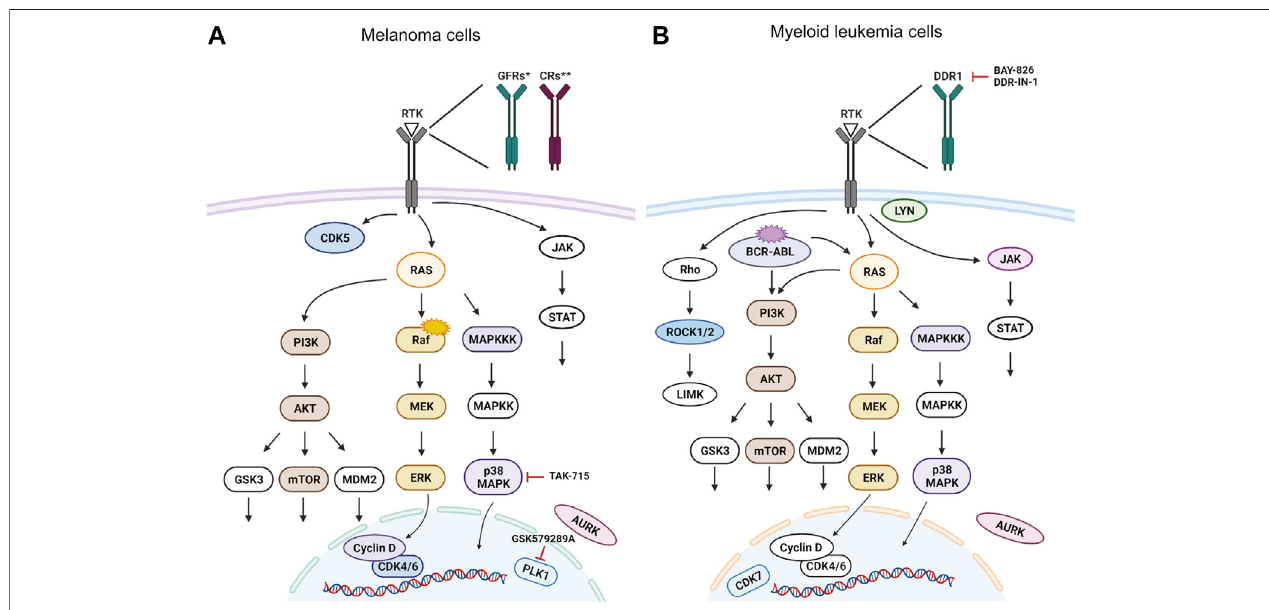
FIGURE 5 | Targeted signaling pathways as predicted from in vivo kinase inhibitor screen. For simplicity, we show the predicted human proteins in this fi gure withoutthezebra fi shparalogs.Proteins,thatweretargetedbyourkinaseinhibitorsetaredepictedincolor,non-targetedonesarewhite.Selectedinhibitorswithapotent new function are depicted in the schemes as well. Signaling pathways in (A) BRAF V600E mutant melanoma cells and in (B) cells of chronic myelogenous leukemia (CML) with BCR-ABL translocation. Figure created in bioRENDER.